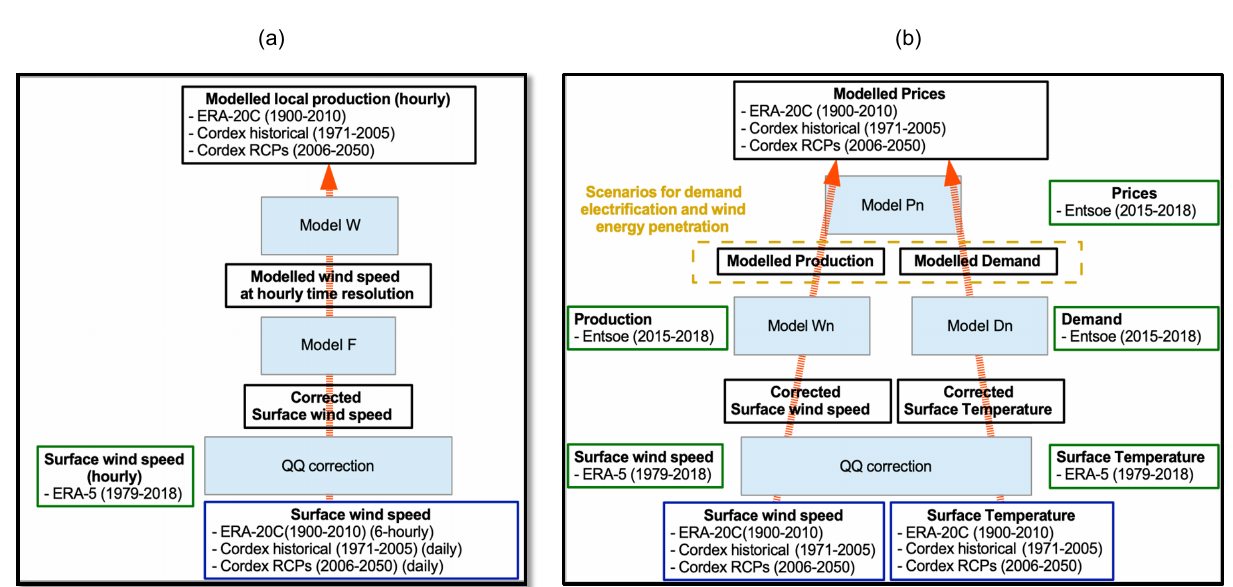
Figure 1. Model schemes for ( a ) local production and ( b ) for country